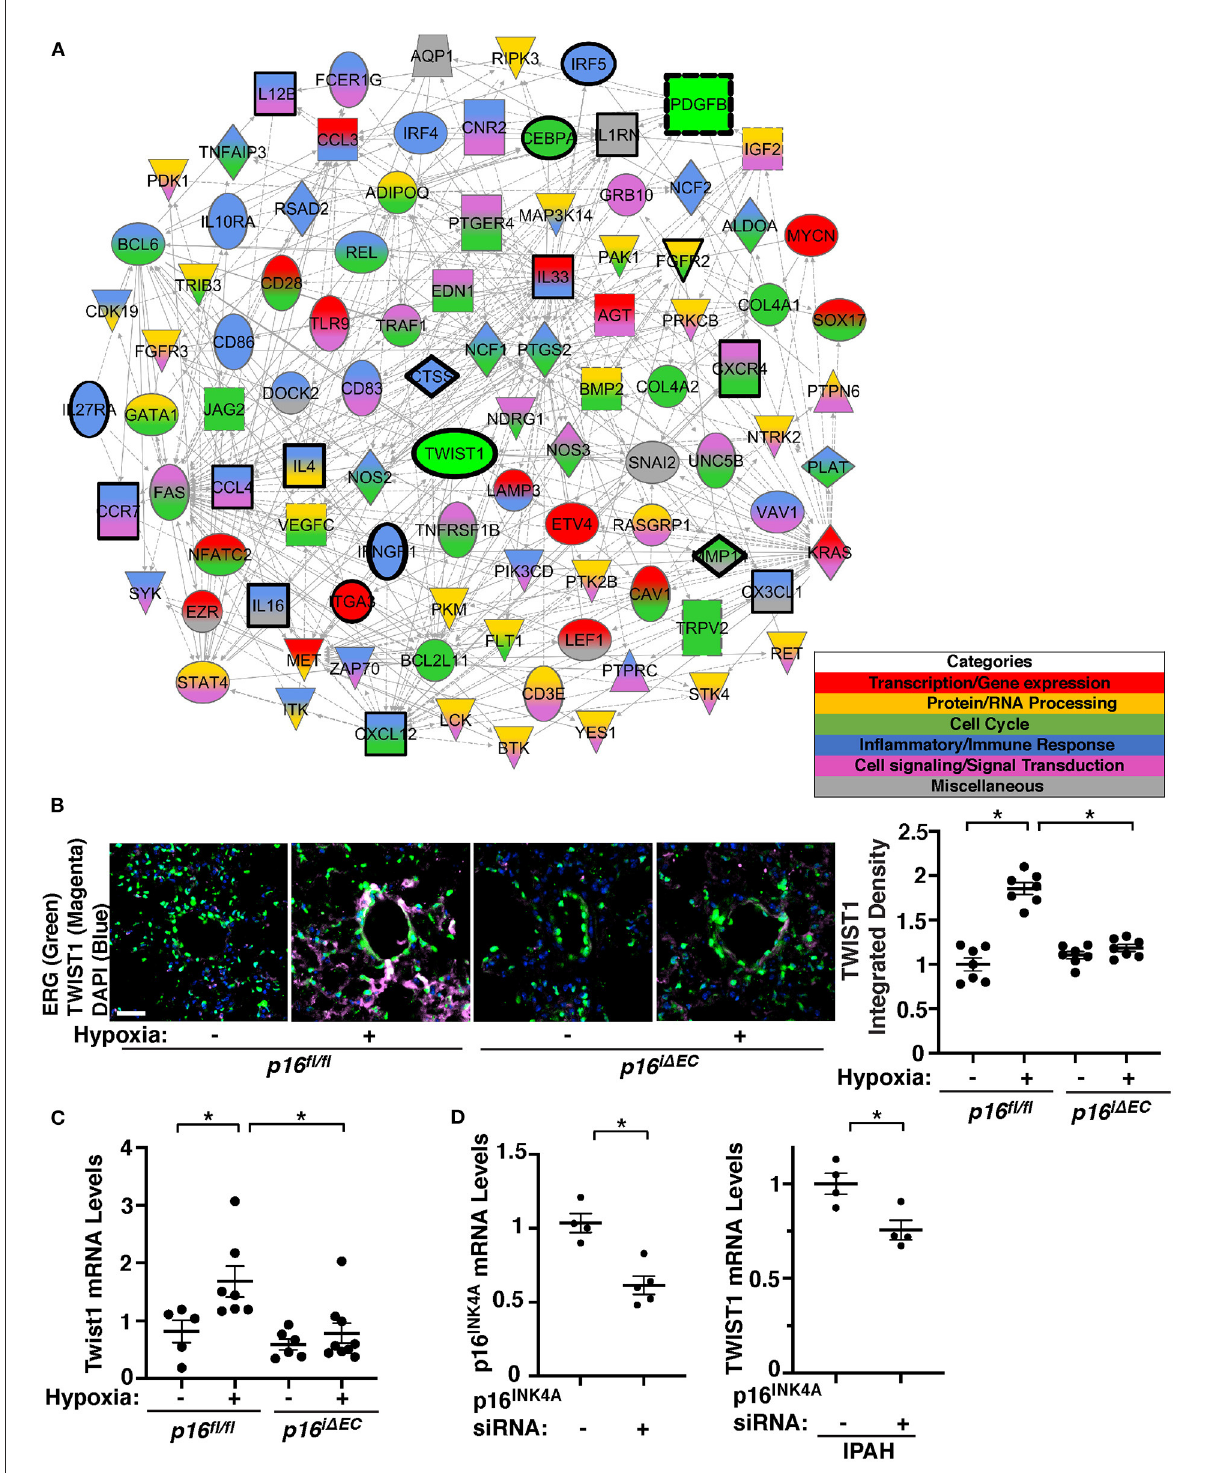
FIGURE3 Endothelial p16 INK4A mediates hypoxia-induced TWIST1 expression in the mouse lung. (A) Gene network demonstrating interactions between Twist1, Pdgfb, and differentially expressed genes listed in the top 50 BP GO Term categories relating to senescence/SASP in ECs isolated from mouse lungs treated with hypoxia for 3 weeks compared to those from normoxia-treated mouse lung ECs. Red: Transcription/gene expression, Gold: Protein/RNA processing, Green: Cell cycle. Blue: Inflammatory/immune response. Pink: Cell signaling/signal transduction,